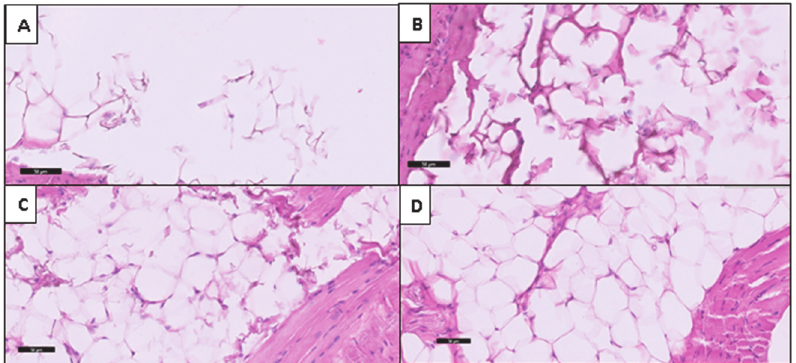
Figure 4. Photomicrographs of a hematoxylin–eosin-stained section of adipose tissue showing the scoring system. ( A ) Score 1: loss of cell wall integrity in most of the adipocytes. ( B ) Score 2: shredded cell wall with minimal preservation of the cell wall of some adipocytes. ( C ) Score 3: fair preservation of the cell wall of adipocytes. ( D ) Score 4: normal preservation of adipocytes (20×). Table 1. Numerical scale for microscopic tissue structures assessment.